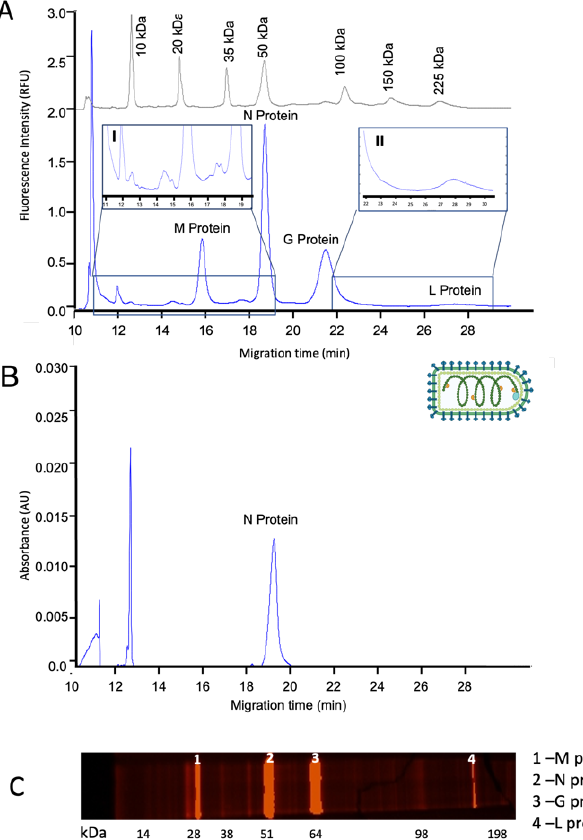
Figure 2. Characterization of MG1 vector. ( A ) Overlay of electropherograms of MW marker (grey line) and purified MG1 sample using CE-SDS with a LIF detector (blue line). I, Zoom-in of impurities profile (RT 11 to 19 min), and II, Zoom-in in L protein elution (RT 22 to 28.5 min). ( B ) Electropherogram of the purified MG1 samples using CE-SDS with a UV detector ( C ) SDS-PAGE with Sypro Ruby staining.